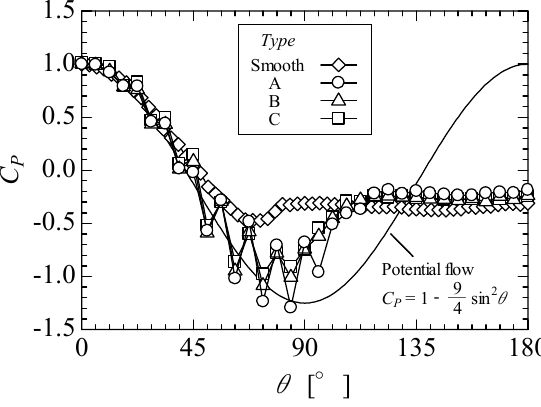
Fig. 4 Pressure distributions on sphere surfaces